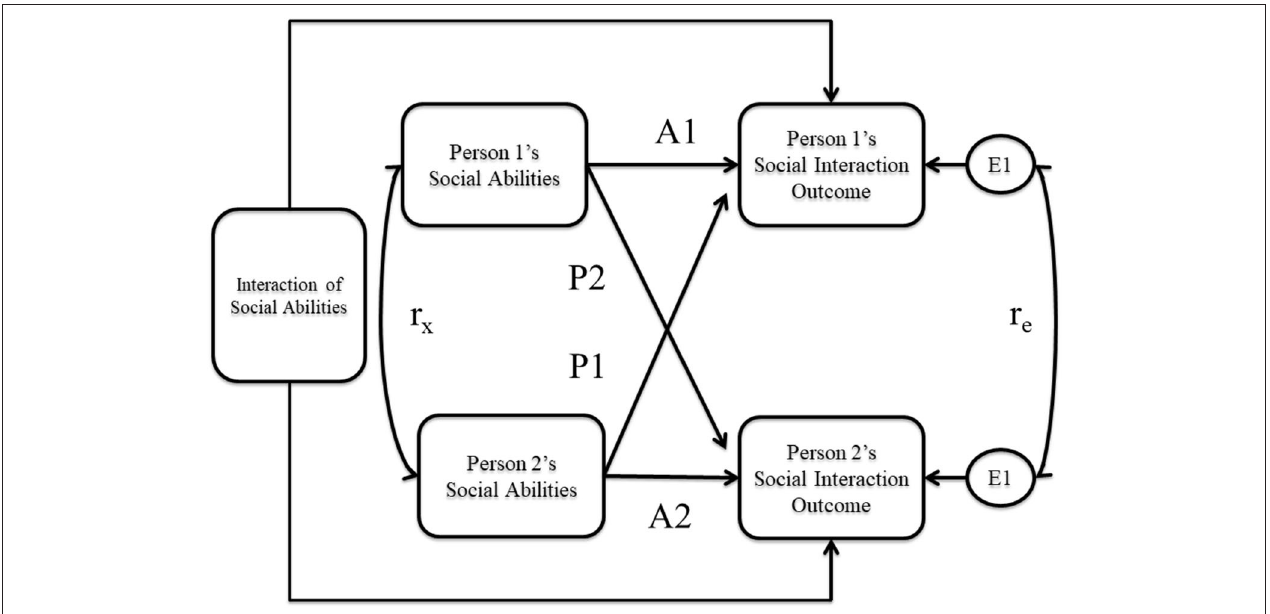
FIGURE 1 | Actor partner interdependence model (APIM) predicting social interaction outcomes with individual and partner social abilities. A-paths represent the actor effects and P-paths represent the partner effects. The interaction term represents the effect of the individual’s social abilities on the individual’s social interaction outcome depending on the partner’s social abilities.